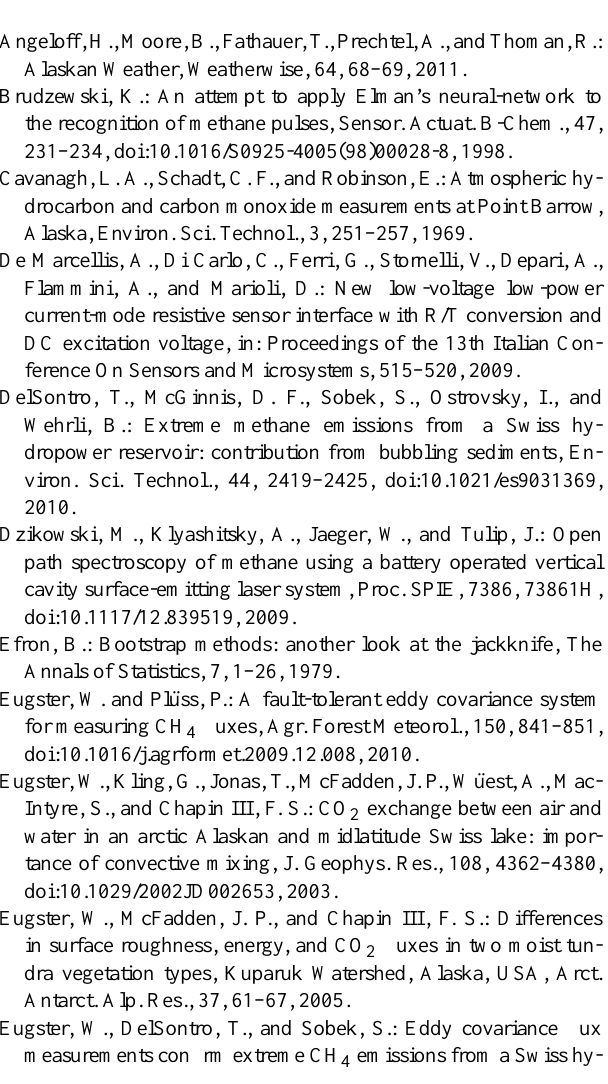
Figaro: TGS 2600 – for the detection of air contaminants, On- line product data sheet, http://www.figarosensor.com/products/ Figaro: Technical information on usage of TGS sensors